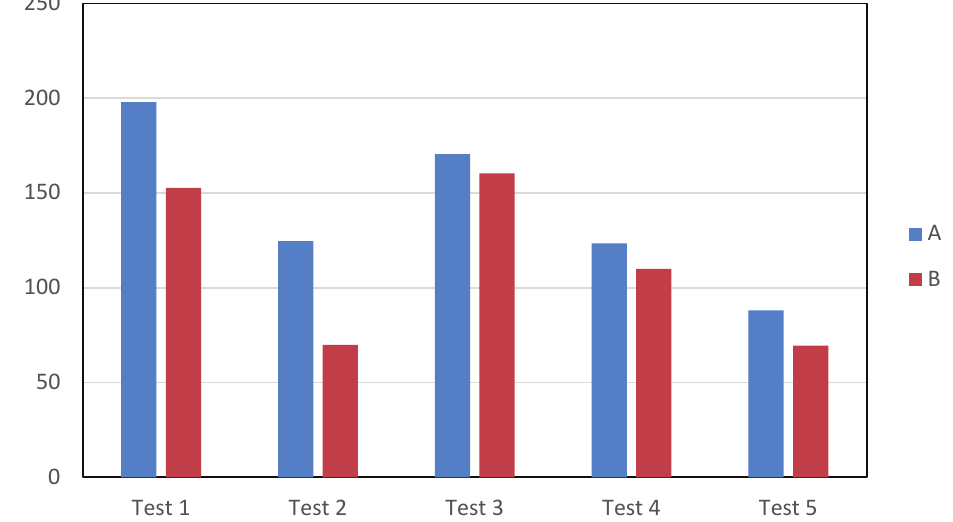
Figure 13. Mean time values (seconds) expended on the performed